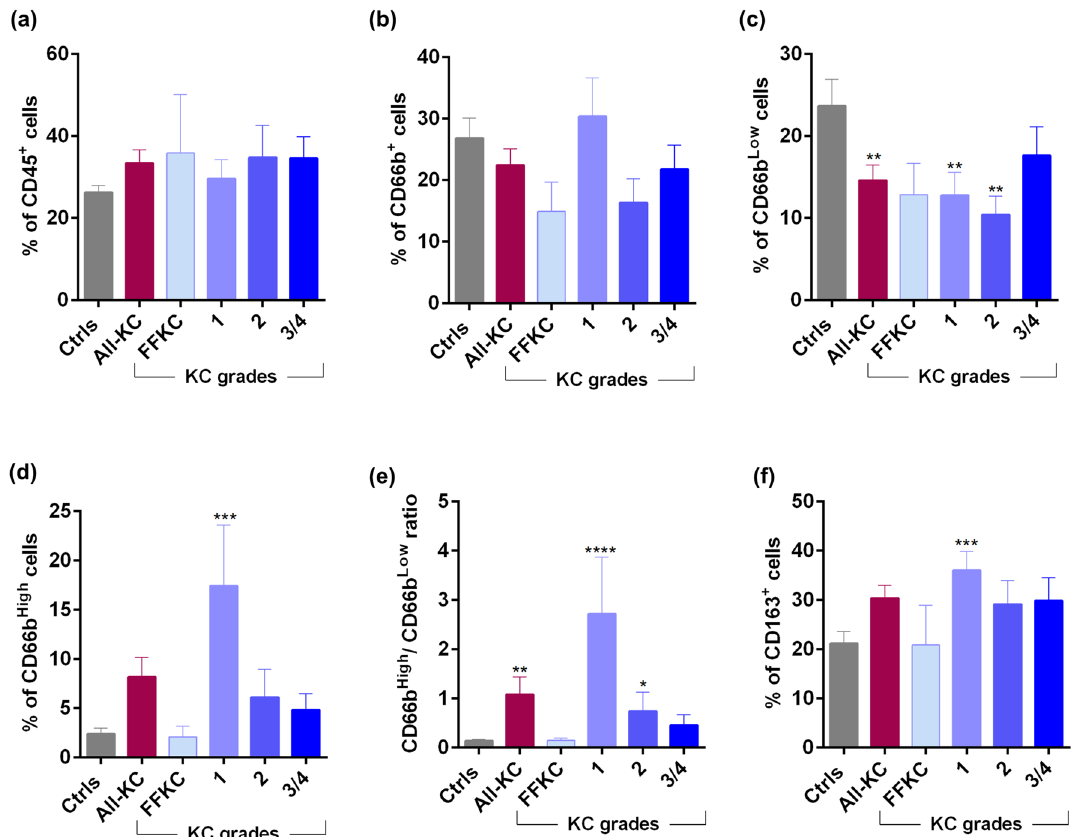
Figure 1. Ocular surface leukocytes, neutrophil subsets and macrophage proportions in KC patients: ( a ) Graph indicates the percentage of CD45 + (Pan leukocyte marker) cells in ocular surface wash samples of eyes with different grades of KC. ( b – e ) Graphs indicate the percentage of CD45 + CD66b Total (Neutrophils), CD45 + CD66b Low (inactive neutrophils), CD45 + CD66b High (activated neutrophils) and the ratio of activated to inactive neutrophils (CD66b High /CD66b Low ) within the leukocyte population in ocular surface wash samples of eyes with different grades of KC. ( f ) Graph indicates percentages of CD45 + CD163 + (macrophages) cells within the leukocyte population in ocular surface wash samples from subjects of eyes with different grades of KC. Ctrls—Controls; FFKC—Forme fruste keratoconus; All-KC—all the grades of keratoconus combined; SEM—standard error of the mean; Controls (23 eyes), All-KC (51 eyes), FFKC (6 eyes), grade 1 KC (14 eyes), grade 2 KC (8 eyes), grade 3 or 4 (23 eyes); Bar graphs represent Mean ± SEM; *P < 0.05, **P < 0.01,***P < 0.001, ****P < 0.0001, Mann–Whitney